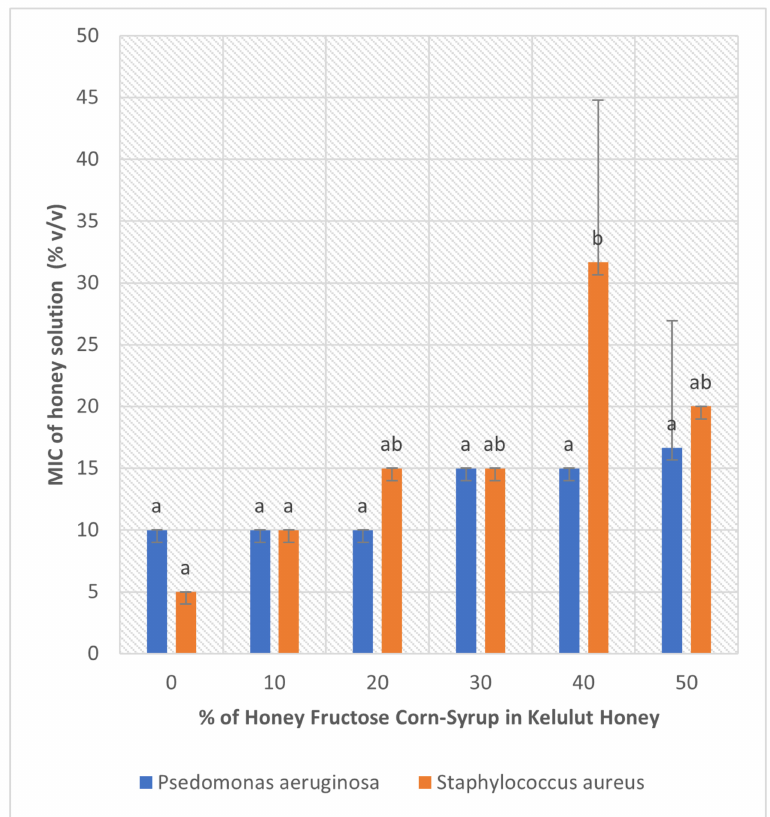
Figure 3. Antibacterial activity of adulterated Kelulut Honey samples of H. itama species with difference concentration HFCS against P. aeruginosa and S. aureus . Note: Means that do not share a letter are significantly